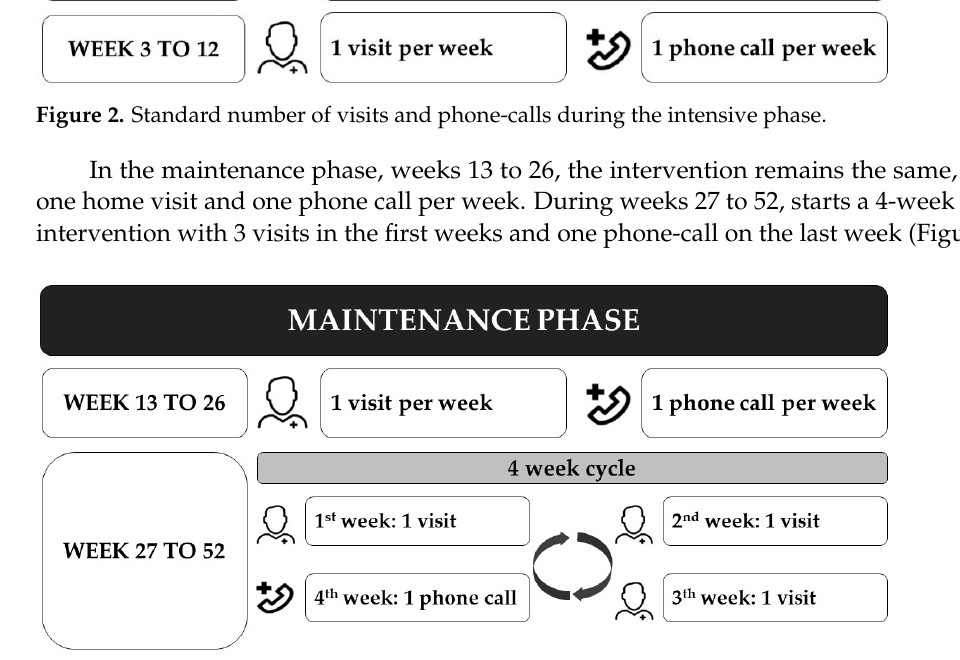
Figure 3. Standard number of visits and phone-calls during the maintenance phase.